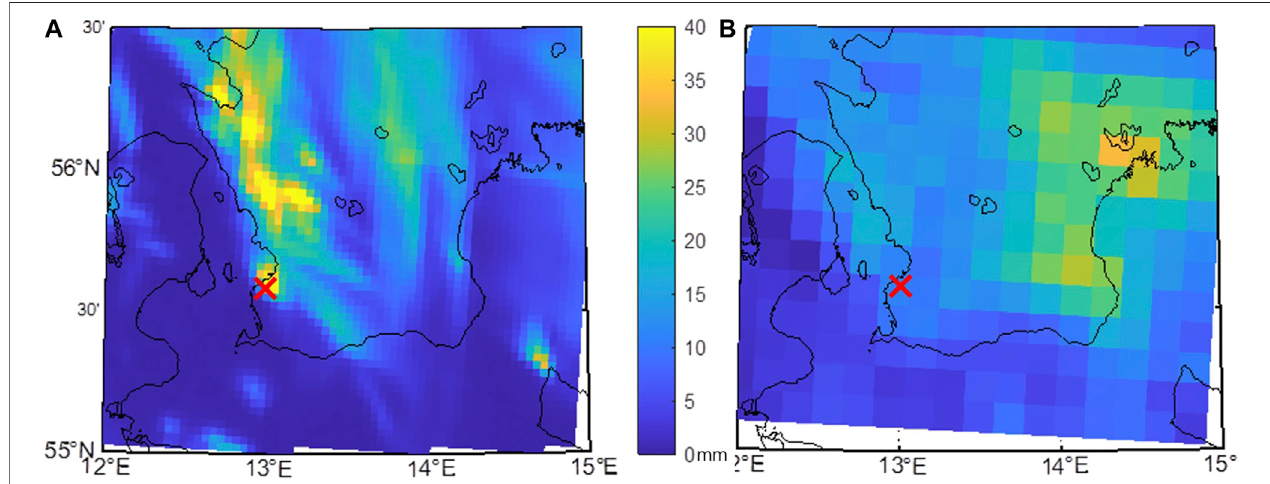
FIGURE 8 | Accumulated daily rainfall simulated by HCLIM3 (A) and HCLIM12 (B) on 2014-08-31 (the Malmö event). The red cross shows the location of Malmö.